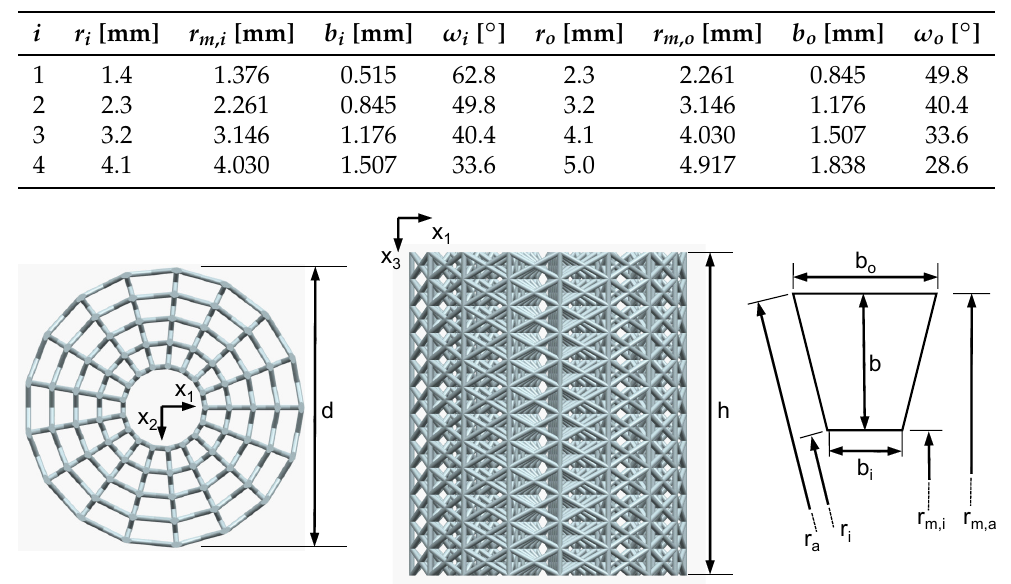
Figure 2. Scaffold geometry used for the